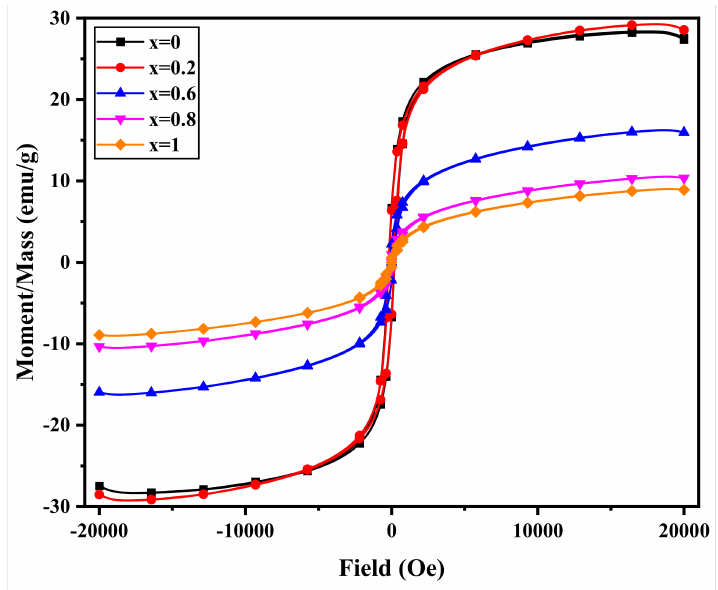
Figure 9. Magnetic hysteresis loops of Ni + 2